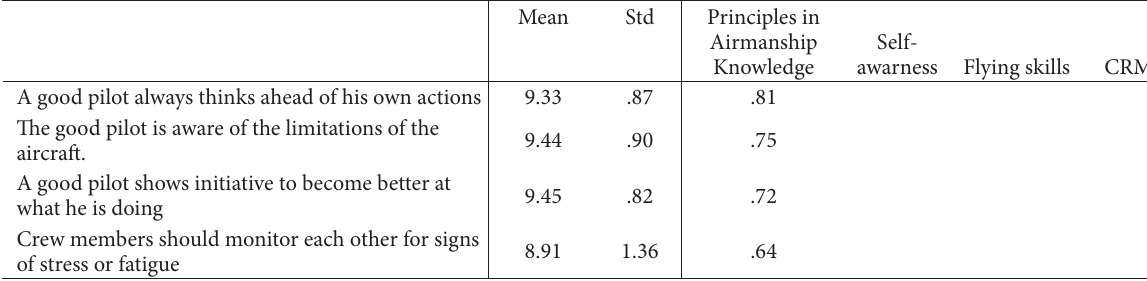
Table 1. Principal component analysis results for attitude items (N =